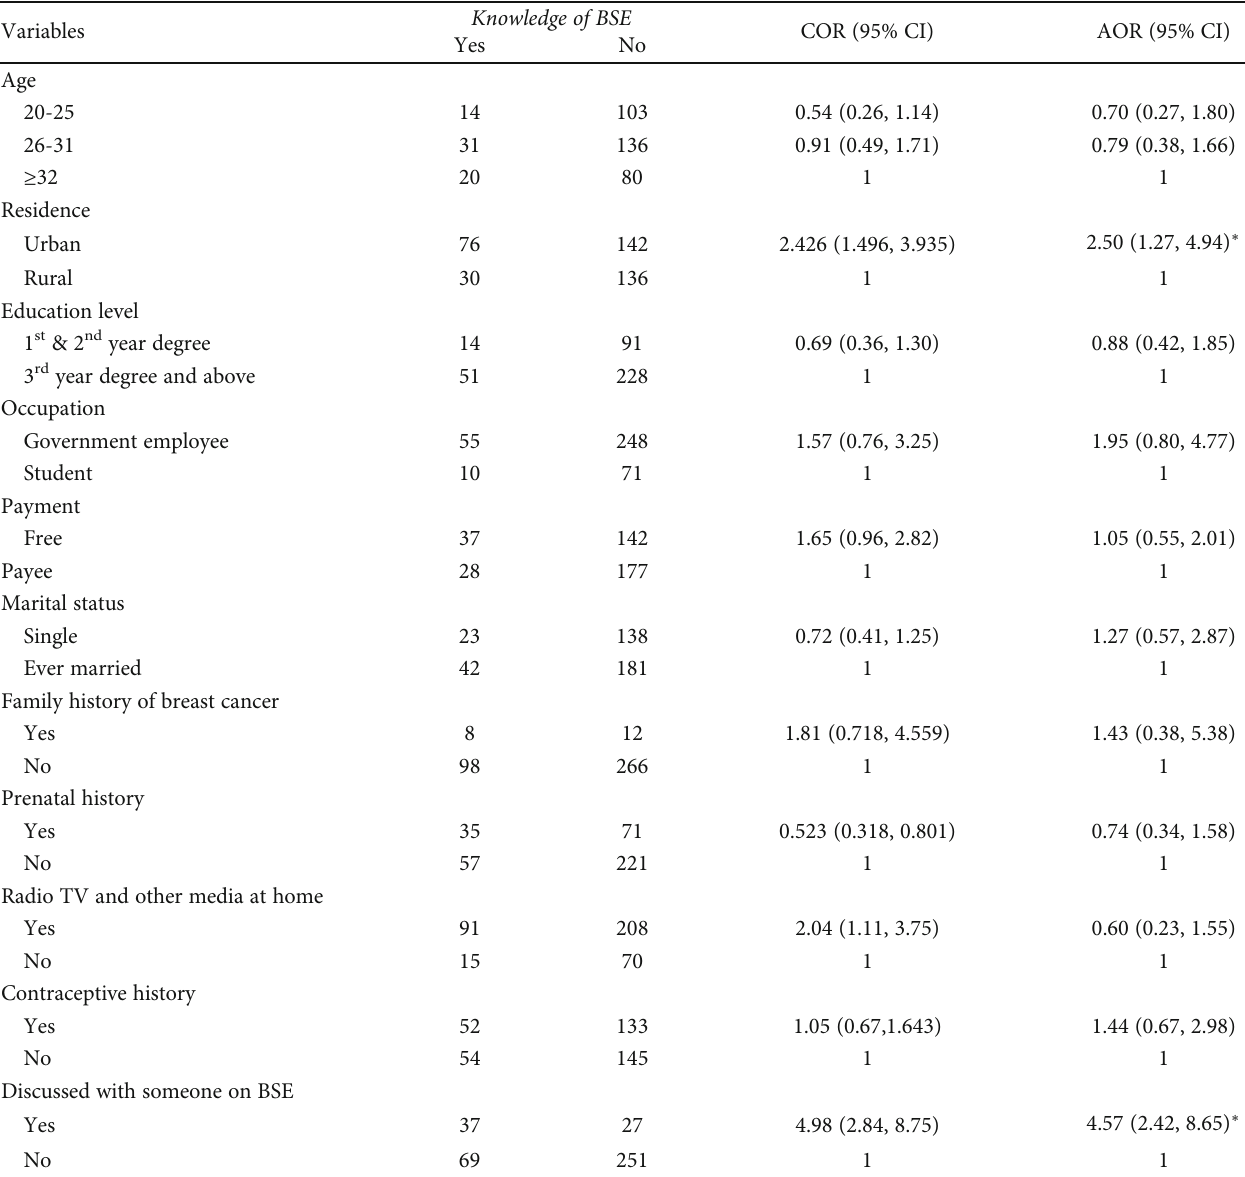
Table 4: Factors associated with knowledge of BSE among summer social science female students in University of Gondar, Northwest Ethiopia ( n = 384